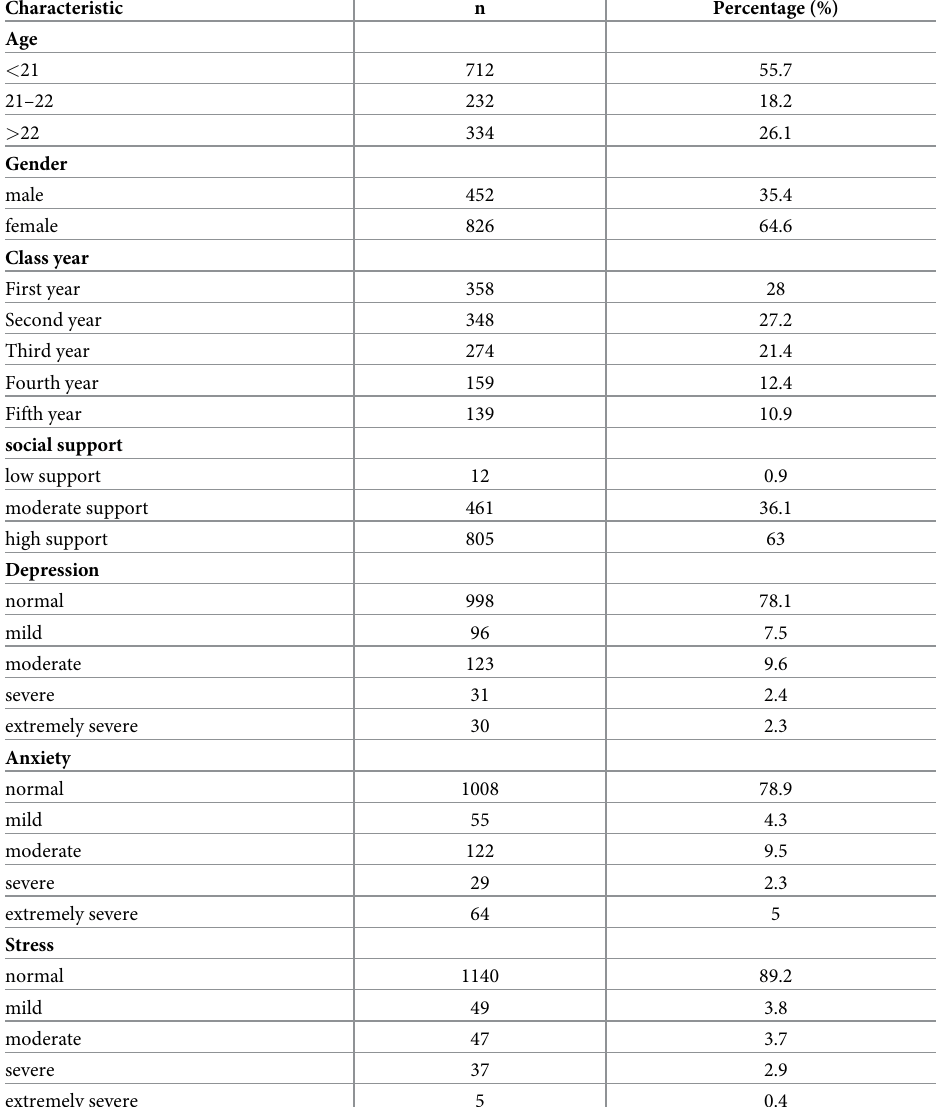
Table 1. Undergraduate student demographic characteristics and the level of mental health symptoms. DOI: 10. 6084/m9.figshare.13106753.